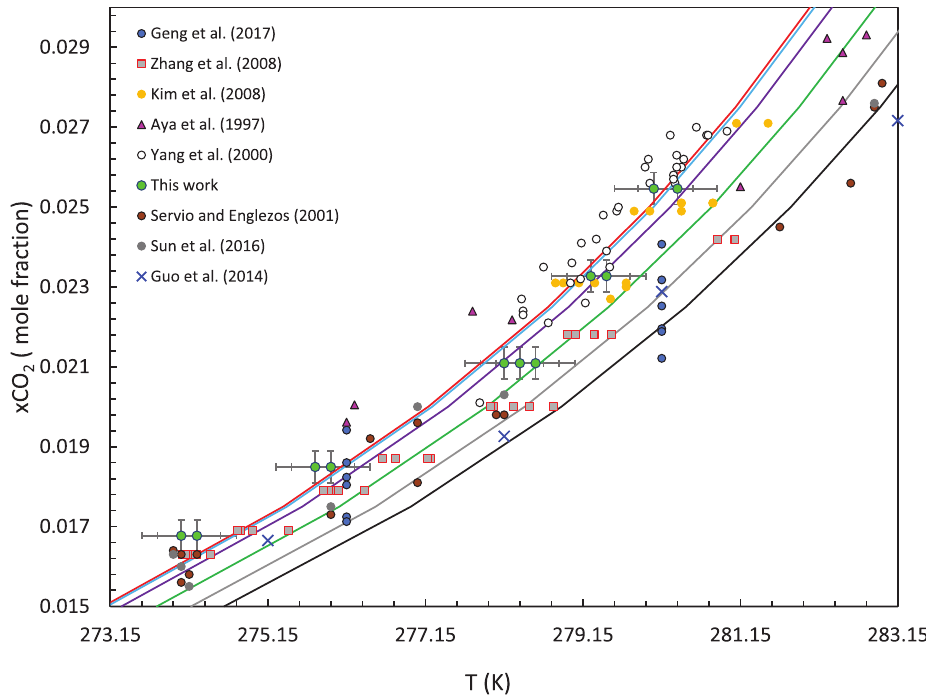
Fig. 8. Comparison of experimental and predicted solubility of CO 2 in water at H – L w equilibria at 5, 6, 10, 20, 30, and 40 MPa (lines from left to right).